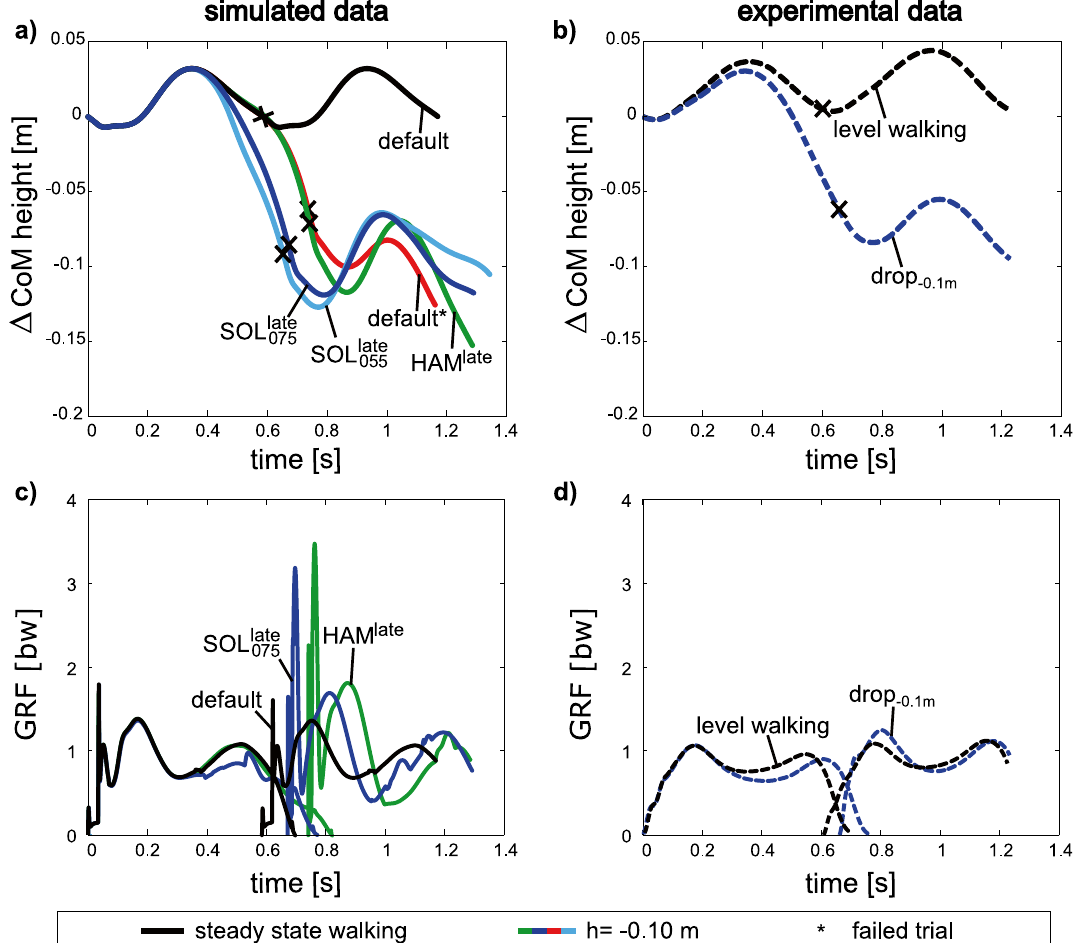
Figure 5. The figure shows the CoM trajectories and ground reaction forces from the heel strike of the preparatory contact (C 0 ) to the heel strike of the contralateral contact (C 2 ) for level and perturbed walking (perturbation height h = − 0.10 m). The left half of the figure presents the simulated data ( a , c ) (horizontal steady-state CoM velocity 1.36 m/s) and the right half presents the experimental data ( b , d ) (horizontal steady-state CoM velocity 1.22 m/s). The CoM trajectories are shifted by the CoM height at heel strike of the preparatory contact. For the lines of the simulated data, on one side trials with the default gain values and on the other side trials of the late anticipatory SOL ( G 0SOL = 0.75/ F maxSOL ; G 0SOL = 0.55/ F maxSOL ) and HAM adjustments ( G 0HAM = 4) were selected. For the vertical ground reaction forces, the simulated data shows a trail with default gains for level walking and trials with the SOL adjustment ( G 0SOL = 0.75/ F maxSOL ) and the HAM adjustment ( G 0HAM = 4) for perturbed walking. Note: The sharp peaks in the simulated data occur because in the model it is assumed that the bones are rigid bodies. In real humans, soft tissue (sometimes termed wobbling masses) comprises the majority of the weight in the legs and trunk. These can shift relative to the bones during impact and have the effect of reducing impact forces 27,28